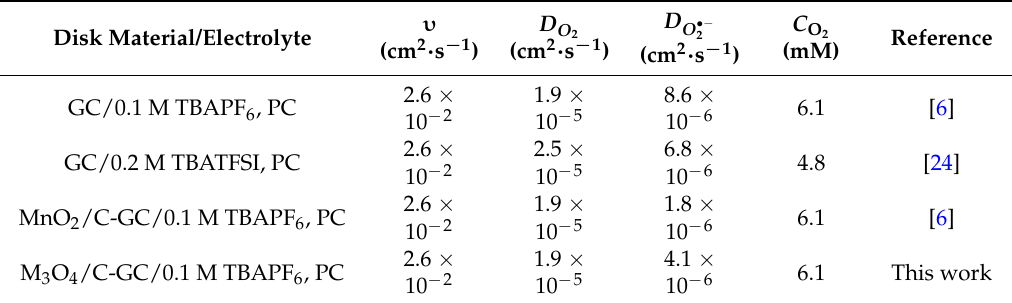
Figure 5. ( a ) Koutecky-Levich (K-L) plots for TX114, P123, F127 and Super P (SP). These are derived from the disc current values at 1.3 V Li ; ( b ) The evolution of the absolute ratio between the ring and the disk current ( N k ) and the electrode rotation rate ( ω ) for TX114, P123, F127 and Super P (SP), recorded at 50 mV · s − 1 in an O 2 -saturated 0.1 M TBAPF 6 /PC solution (see Figure 4). Table 2. Summary of the electrolyte properties estimated with the proposed rotating ring-disk electrode (RRDE)-based methodology and comparison with the findings reported in the literature. D υ D O C O O •− 2 Disk Material/Electrolyte Reference 2 2 (cm 2 · s − 1 ) (cm 2 · s − 1 ) (mM) (cm 2 · s − 1 ) GC/0.1 M TBAPF 6 ,